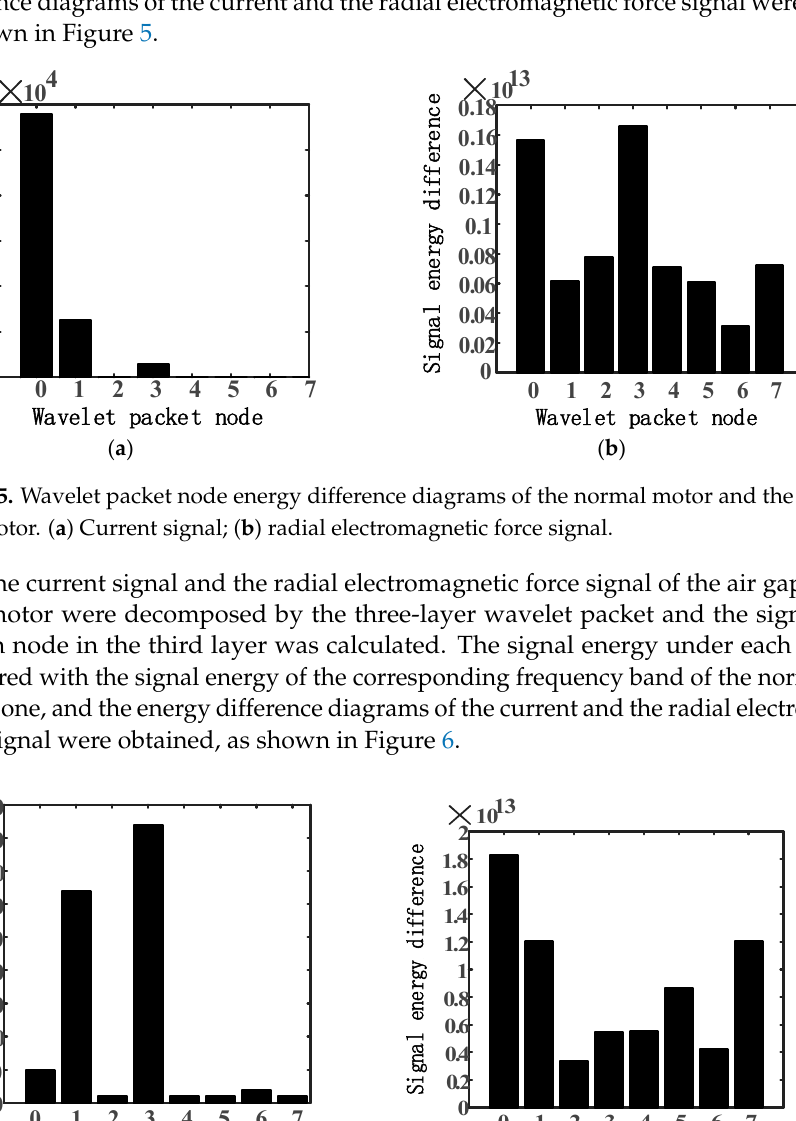
( b ) Figure 7. Wavelet packet node energy difference diagrams of the normal motor and the stator inter- turn short-circuit fault motor. ( a ) Current signal; ( b ) radial electromagnetic force signal. According to the results of the wavelet packet energy analysis, the motor fault infor- mation was mainly contained in the first, second, and fourth frequency bands of the third- layer wavelet packet of the current signal, and in the first, second, fourth, fifth, and eighth frequency bands of the third-layer wavelet packet of the radial electromagnetic force sig- nal. Therefore, the energy of the above eight frequency bands was selected as the input vector of the BP neural network. The neural network output layer externally outputs the results of the network training. As the identification and classification of motor faults were involved, the output layer corresponded to the four operating conditions of the submers- ible motor (specifically: 1000 corresponded to normal operation; 0100 corresponded to the rotor broken bar fault; 0010 corresponded to the air gap eccentric fault; and 0001 corre- sponded to the stator inter-turn short-circuit fault). For the design of the hidden layer neurons, the number of hidden layer nodes is gen- erally determined by an empirical formula, as shown in Equation (6). s